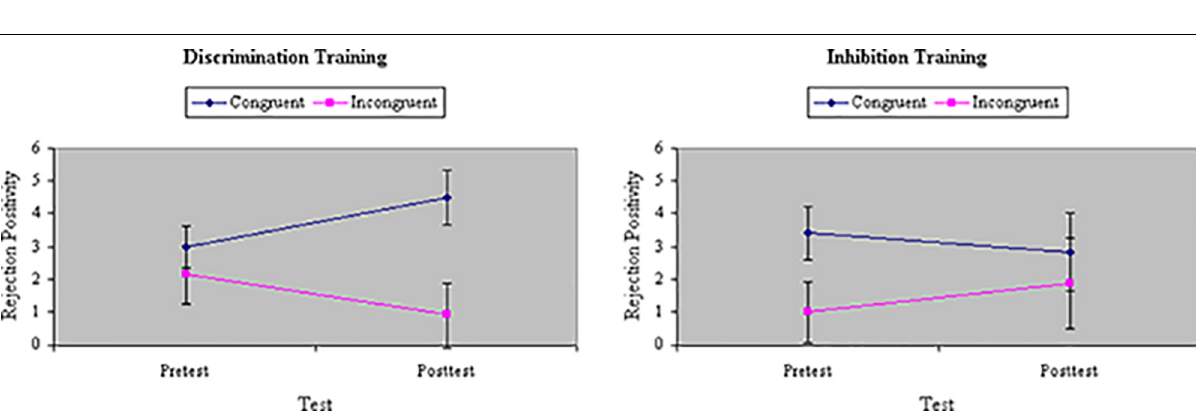
FIGURE 10 | Event-related potential waveforms to the initial flanker on incongruent trials at pretest and posttest over six centroparietal electrode locations (E2, A1, C3, E25, A3, and B24), separately for participants in discrimination training and inhibition training. Inhibition training decreased P3 to these stimuli, 400–900 ms after stimulus onset, whereas discrimination training increased P3 to these stimuli.